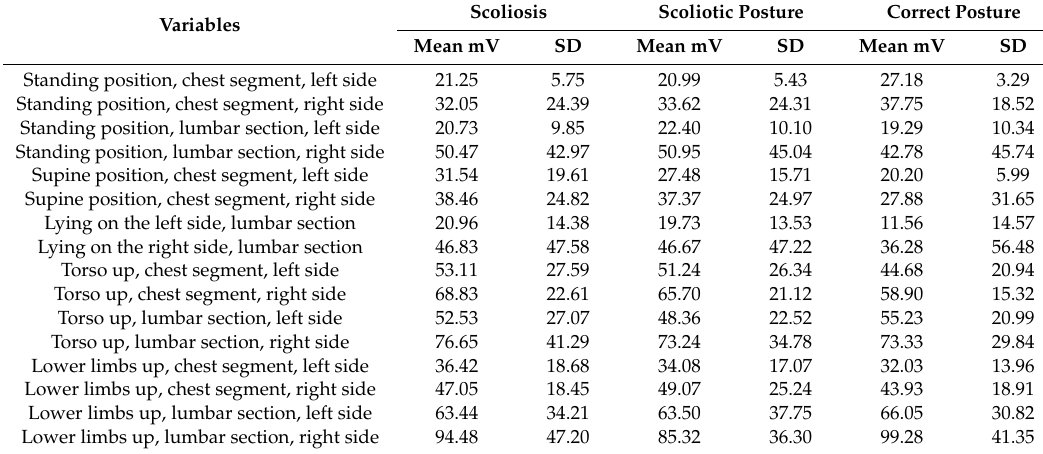
Table 2. Surface electromyography (SEMG) amplitude of the erector spinae in girls. Variables